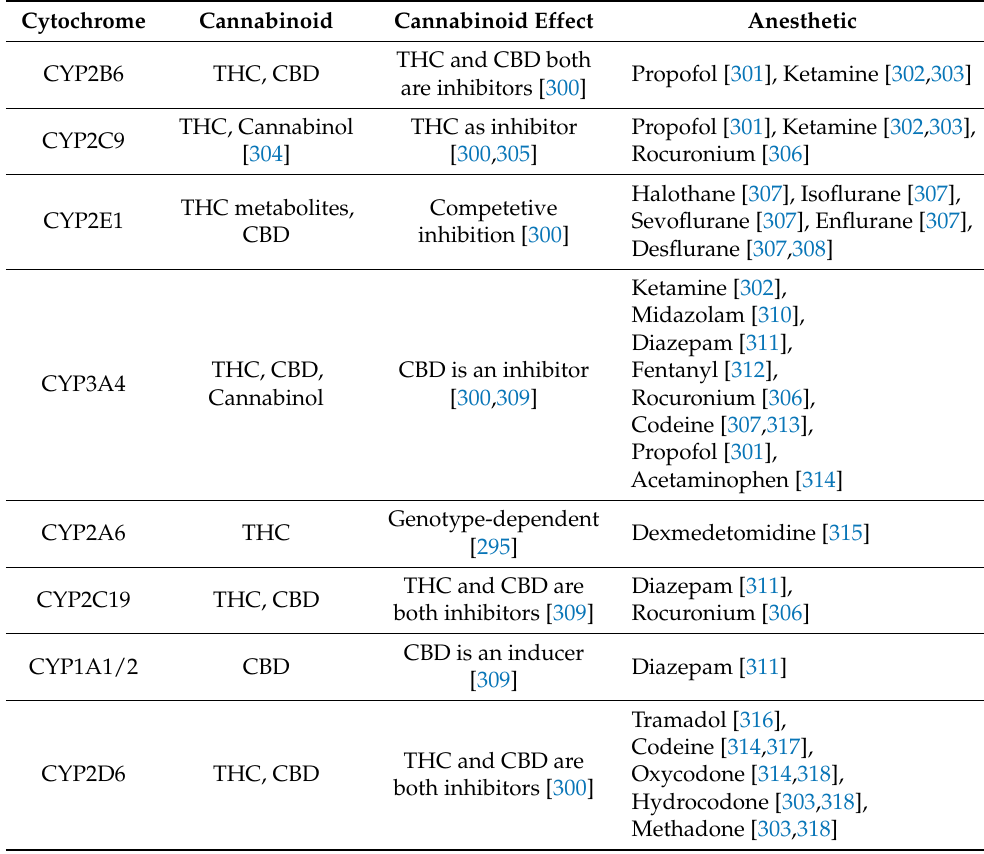
Table 3. Interaction between cytochromes and anesthetic agents while being modulated by